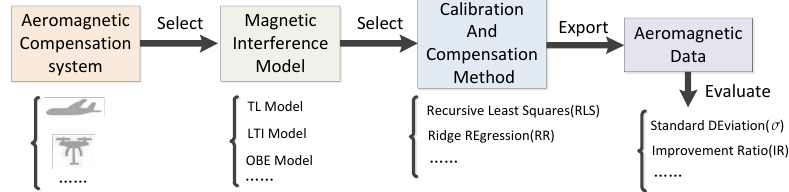
Figure 1. Aeromagnetic compensation technology